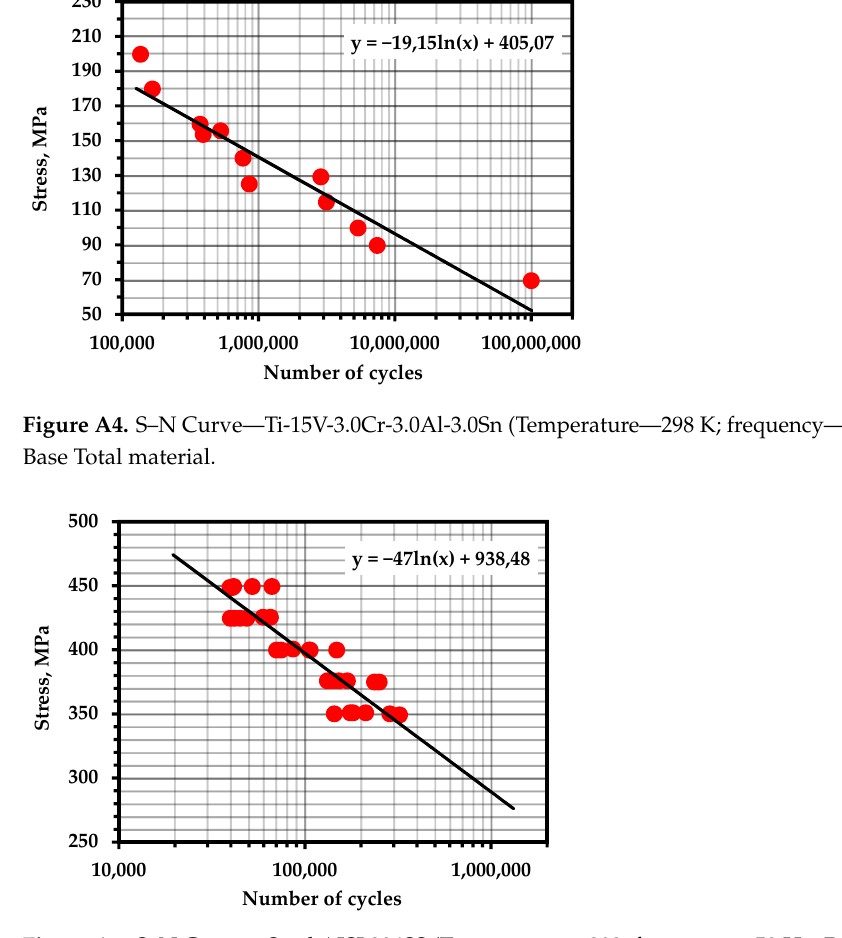
Figure A5. S–N Curve—Steel AISI 304SS (Temperature—293; frequency—50 Hz; R = 1.5) [100].